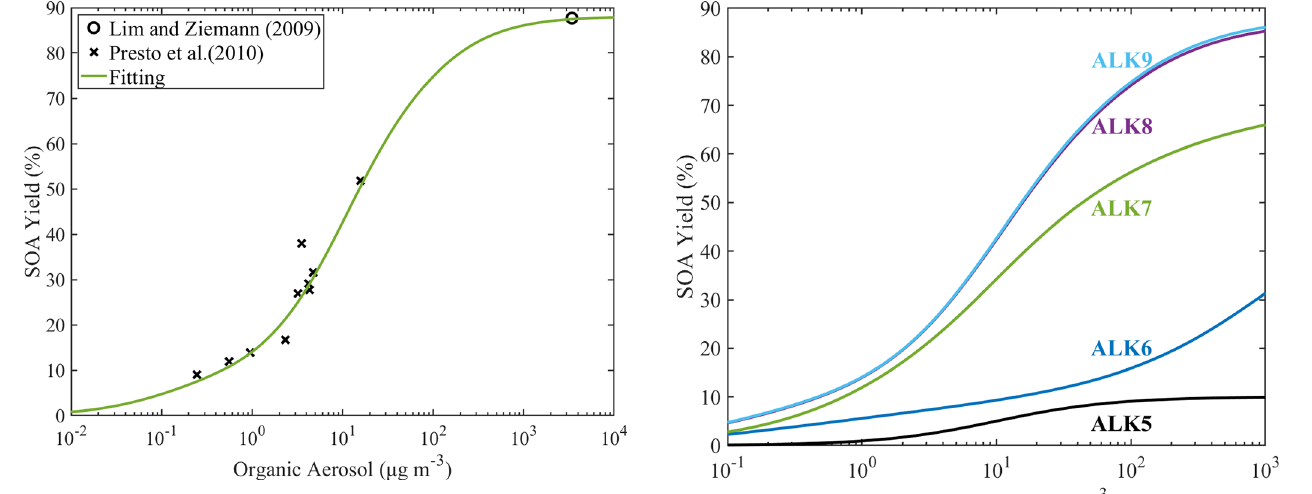
Figure 7. Estimated SOA yields of n -heptadecane under high-NO x conditions. The curve is generated using the estimated values of a i (0.0771, 0.024, 0.6291, 0.1506 and 0). The data from the studies of Lim and Ziemann (2009) and Presto et al. (2010) that were used by the simplified algorithm are also shown.